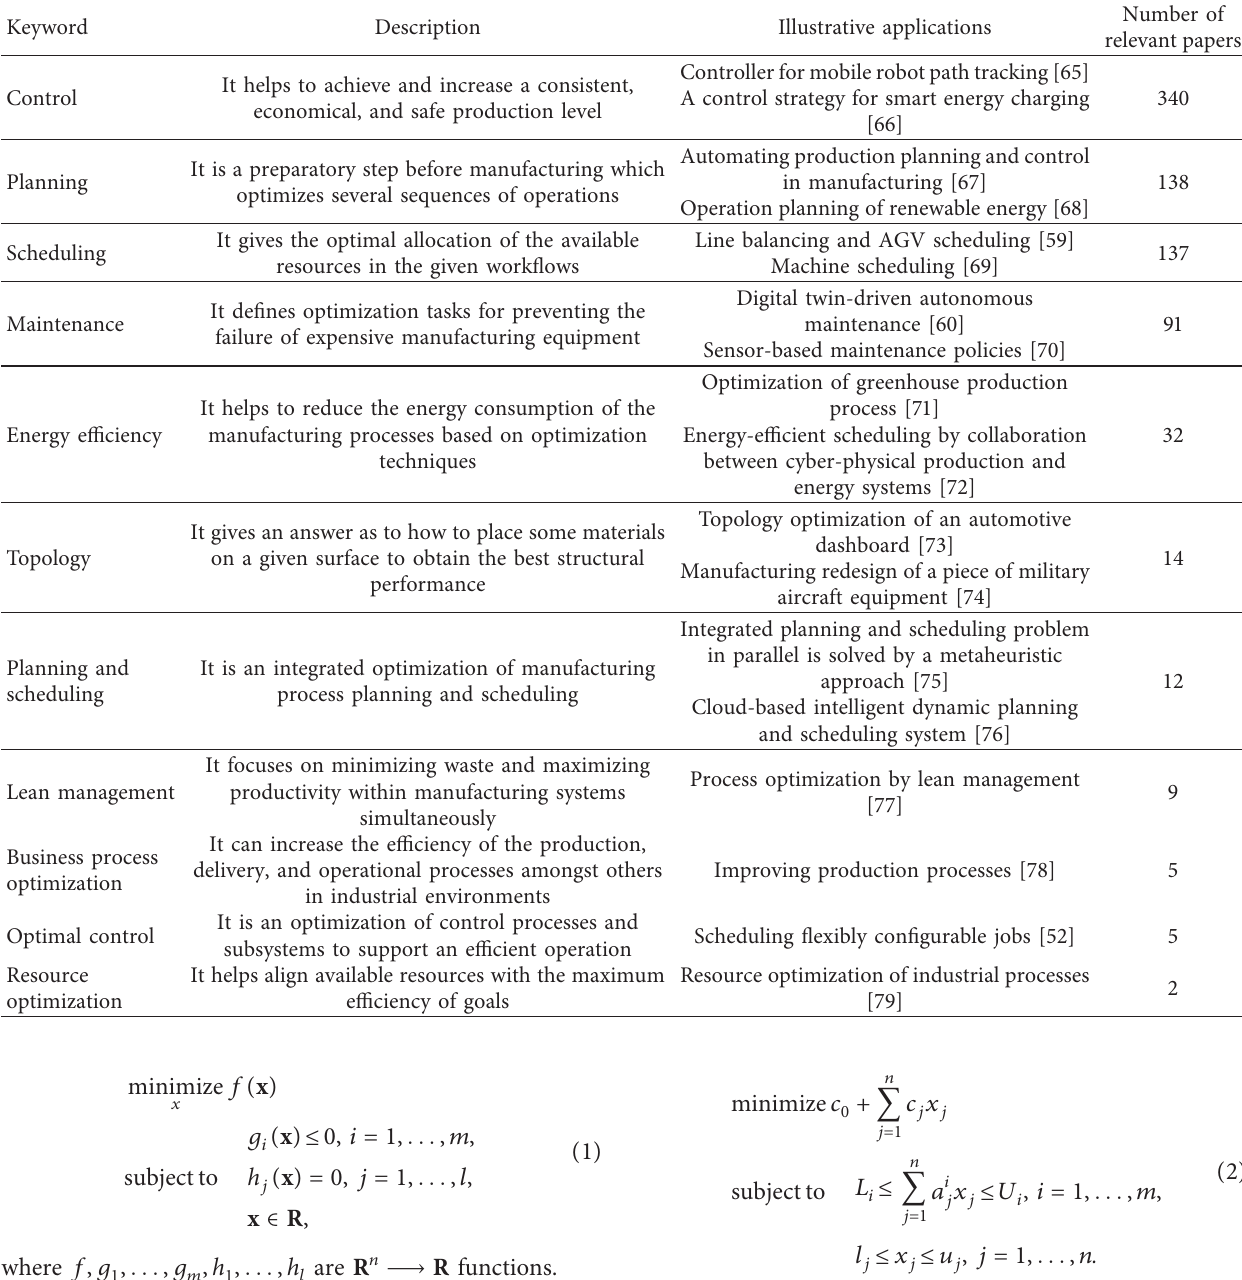
Table 5: I40-relevant application areas of optimization